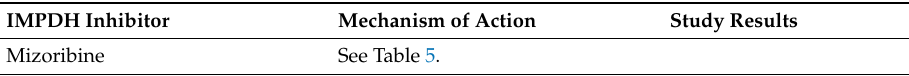
Table 7. Summary of IMPDH inhibitors as